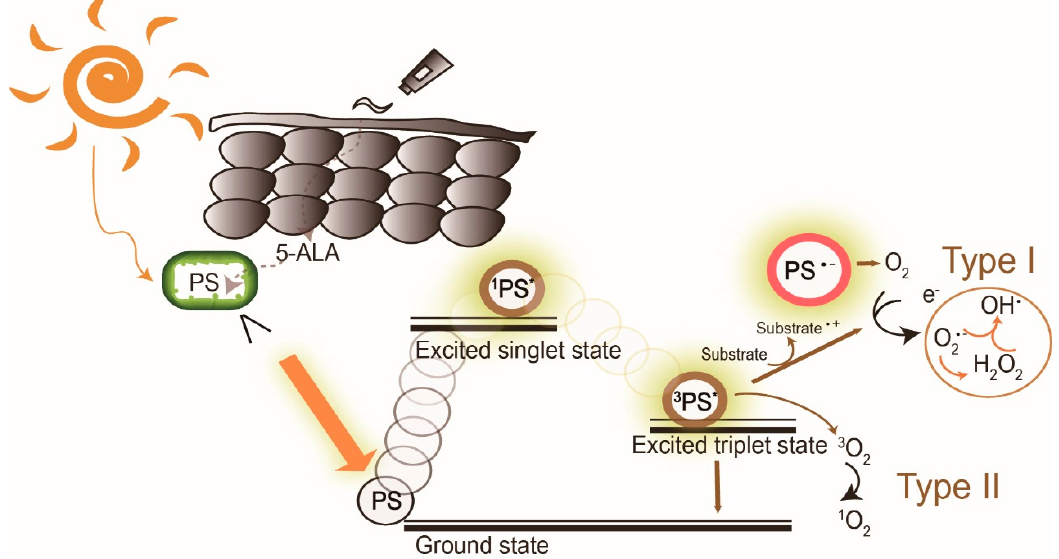
Figure 1. The mechanism of daylight photodynamic therapy. After daylight absorption, the photosensitizer (PS, 5-aminolevulinic acid (5-ALA), a prodrug of the real PS protoporphyrin IX, is exemplified here) is excited to a singlet state and undergoes intersystem crossing to the excited triplet-state. The triplet excited PS can react in two ways: a Type I reaction which involves the generation of superoxide anion radical (O 2 •− ), hydrogen peroxide (H 2 O 2 ), and hydroxyl radical (OH • ) by electron transfer to molecular oxygen, and / or by the type II reaction through energy transfer to generate singlet oxygen ( 1 O2). PS: photosensitizer; 1 PS*: excited singlet state, 3 PS* excited triplet state.